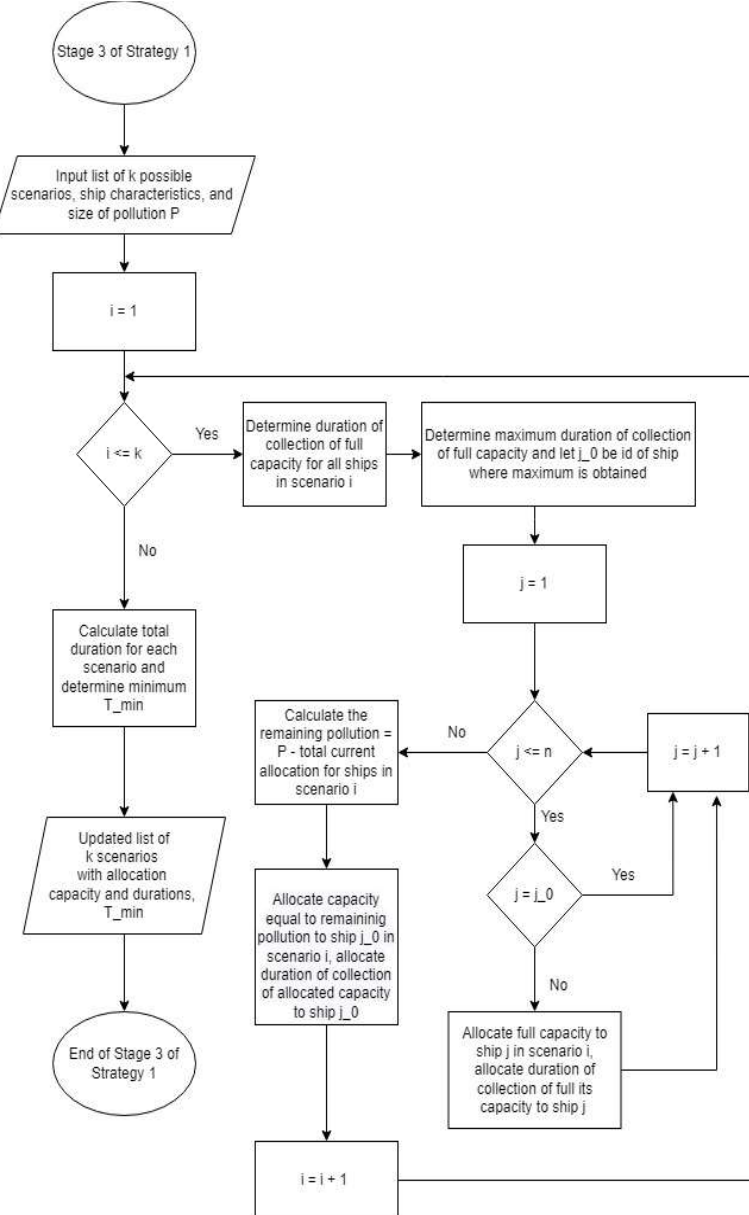
Figure 9. Flowchart for Stage 3 of Strategy 1.